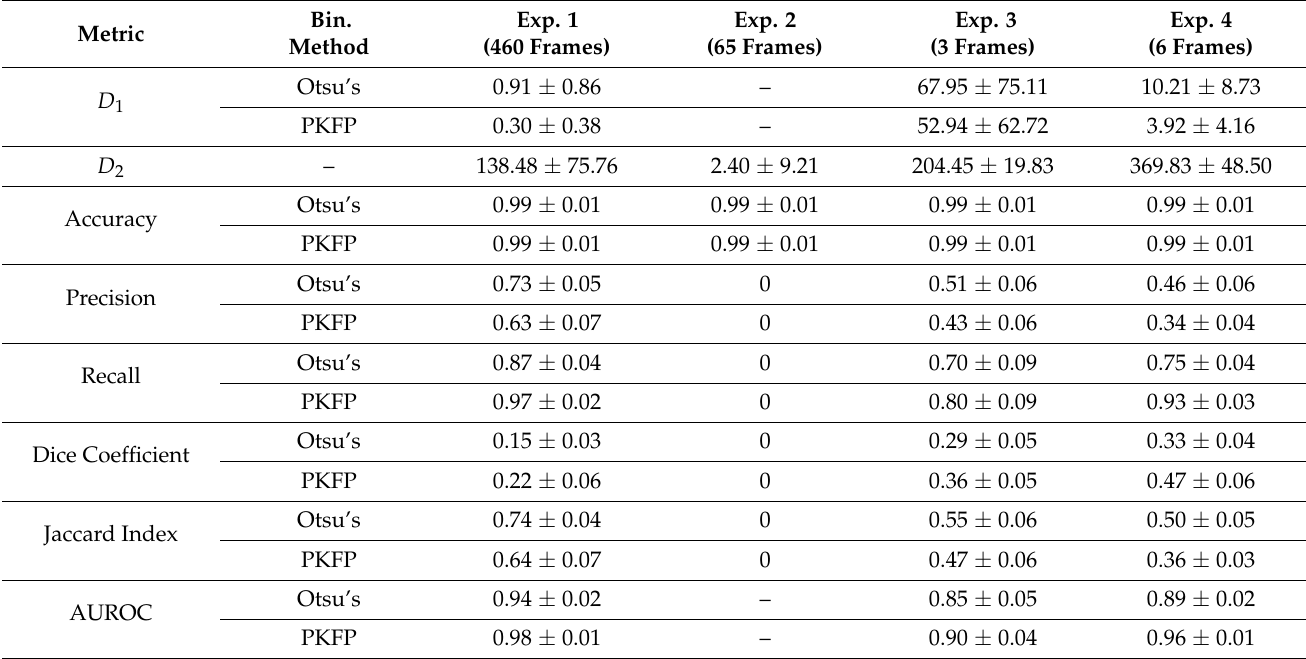
Table 2. Results of the selected model in the